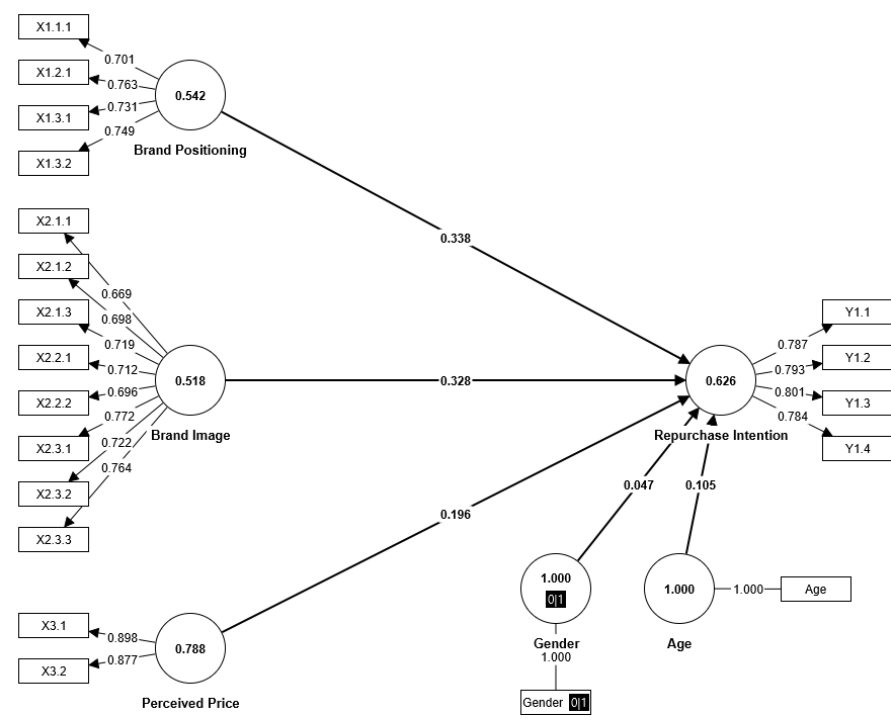
Figure 2. PLS Path